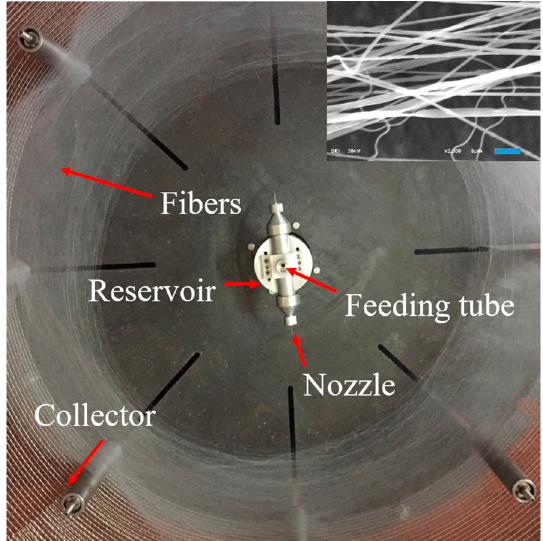
Figure 1. PEO nanofibers fabricated from centrifugal spinning machine via 6 w/v% PEO solution with 4000 rpm, 0.15 mm nozzle diameter and 13 mm nozzle length. The inset is the SEM image of the obtained fibers, the scale bar is 5 µm.